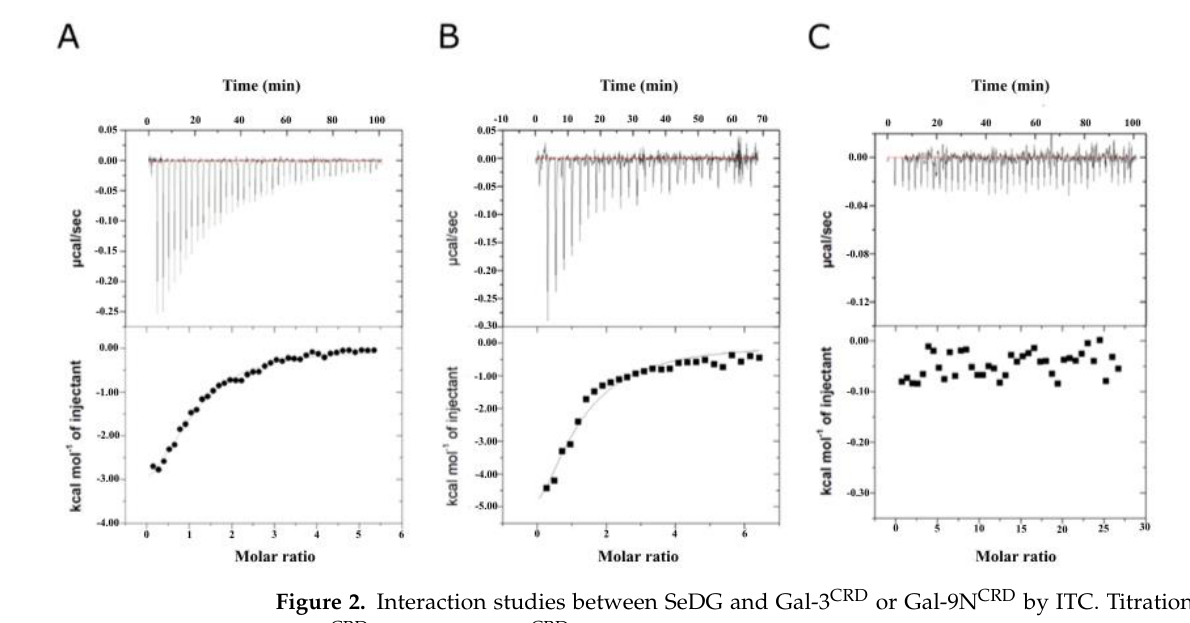
Figure 2. Interaction studies between SeDG and Gal-3 CRD or Gal-9N CRD by ITC. Titration of ( A ) Gal-3 CRD and ( B ) Gal-9N CRD with SeDG. Titration of ( C ) buffer with SeDG-Bn (negative control). The upper panels of the graphs depict the injections, while the lower panels depict the integrations of the peaks according to the molar ratio of the molecules tested. Table 1. Thermodynamic binding parameters of Gal-3 CRD and Gal-9N CRD titrated with SeDG and SeDG-Bn at 298 K.